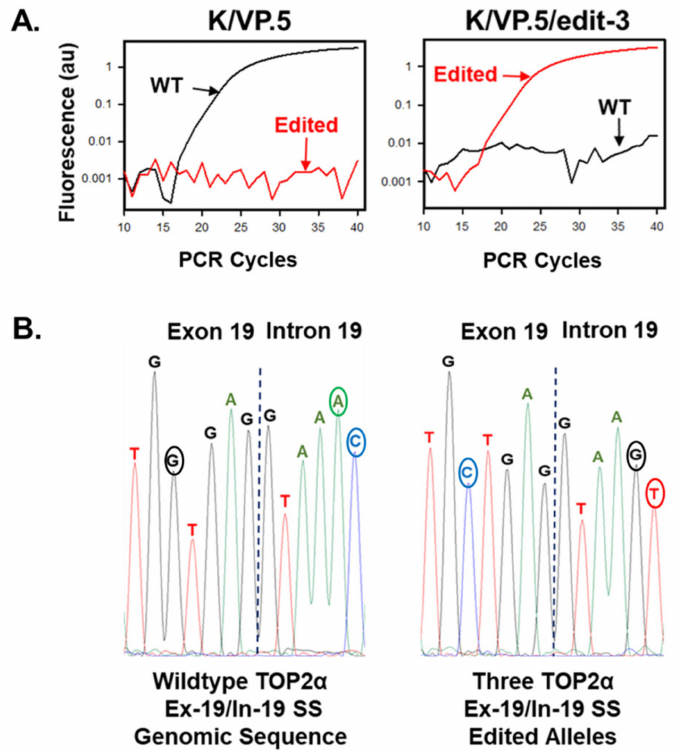
Figure 9. Selection and identification of a CRISPR/Cas9-edited TOP2 α E19/I19 5 (cid:48) SS clonal cell line. ( A ) qPCR results from K/VP.5 and K/VP.5/edit-3 cells using wild-type and edited specific E19/I19 boundary qPCR probes. ( B ) Genomic sequencing of the TOP2 α E19/I19 boundary in K/VP.5